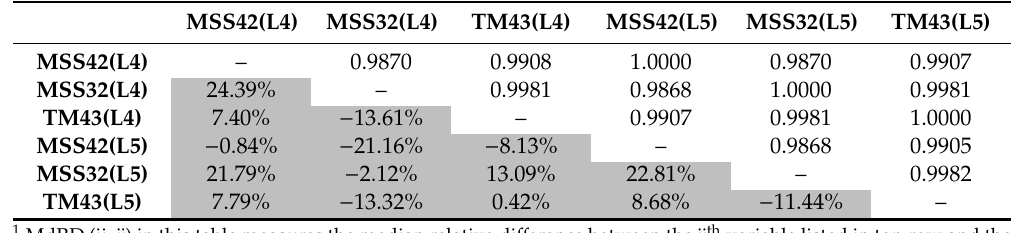
Figure 3. Illustrations of channel reflectance for the approximately corresponding channels of MSS and TM, onboard Landsat 4 (L4) (top row) and Landsat 5 (L5) (bottom row). The channels over red and NIR regions are presented, which were used for normalized di ff erence vegetation index (NDVI) calculation. General di ff erences are presented, including the median di ff erence (MdD, Equation (7)) and the median relative di ff erence (MdRD, Equation (8)). To get the di ff erence measures, variables for TM were used as references respectively. The black dashed lines in all subplots are 1:1 lines superimposed for reference. Data density is indicated by color, with color from blue to red representing the data density from low to high. Table 3. General comparison of the NDVIs obtained through di ff erent sensors (channels) onboard Landsat 4 (L4) and Landsat 5 (L5), based on simulation results from 10,000 Hyperion spectra samples. In this table, two di ff erence measures are presented, including the median relative di ff erence (MdRD 1 (Equation (8)), filled with gray background) and the correlation coe ffi cient through Spearman rank